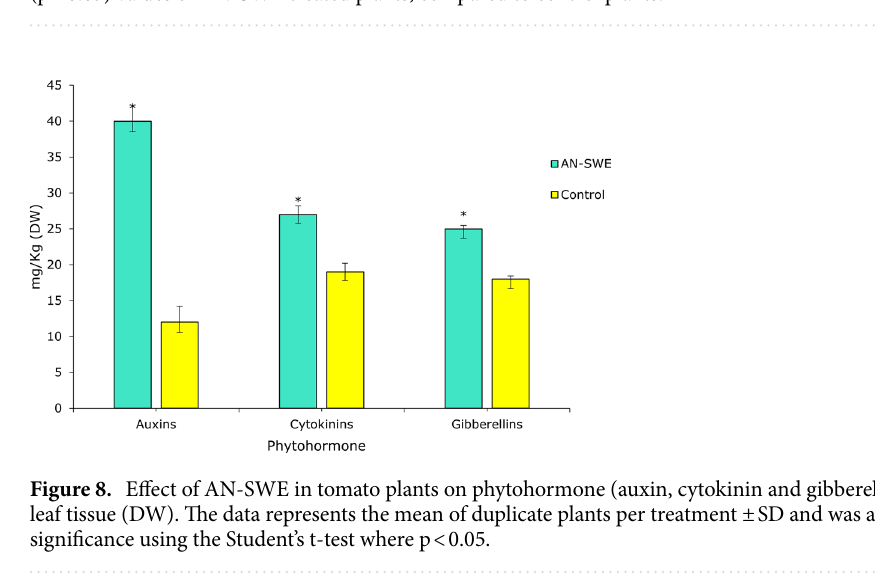
Figure 7. Effect of treatment with AN-SWE on plant defence enzyme activities in tomato plants. β-1,3 glucanase (GLU), peroxidase (POD), phenylalanine ammonia lyase (PAL), chitinase (CHI) and polyphenol oxidase (PPO). The data represents the mean of three plants per treatment that were analysed for significance by the Student’s t-test. Horizontal bars signify one standard deviation and “*” represents significantly different (p < 0.05) values of AN-SWE treated plants, compared to control plants.